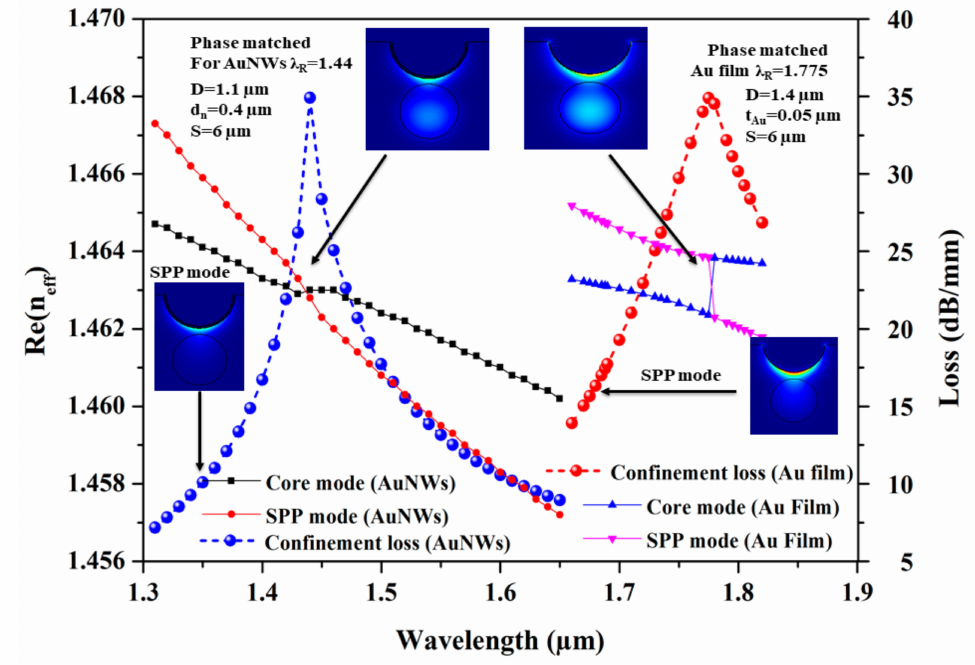
Figure 2. Dispersion curve for both Au thin film /